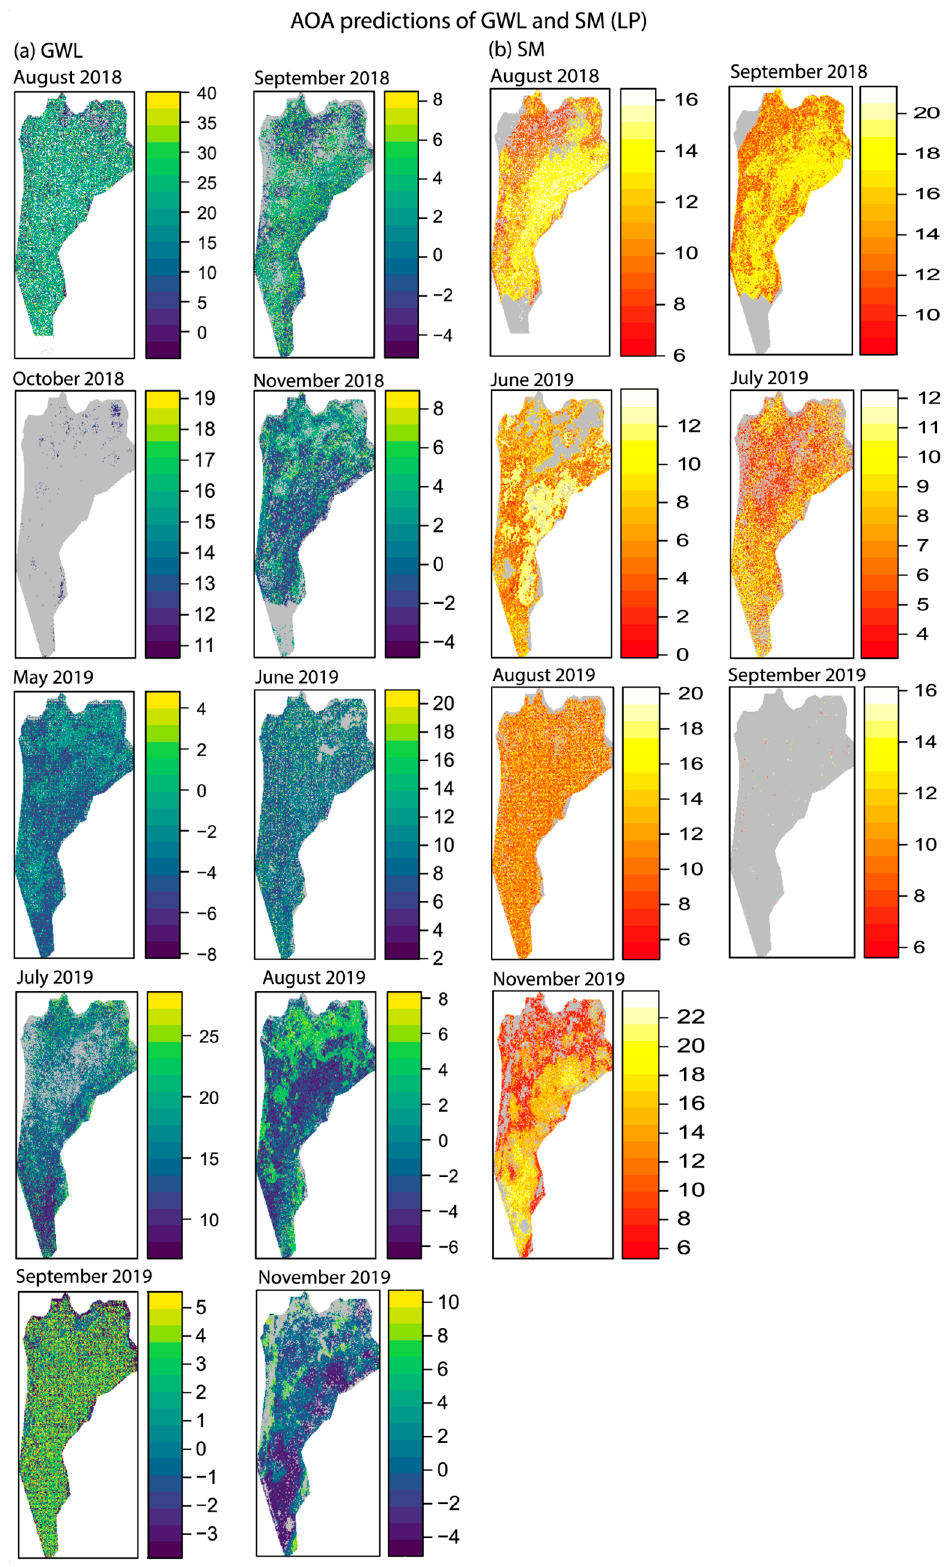
Figure 11. ( a ) GWL (August 2018-November 2019; blue-green) and ( b ) SM (August 2018-November 2019; orange-yellow) predictions of the LP masked by the derived AOA where areas outside the AOA are exposed in gray.